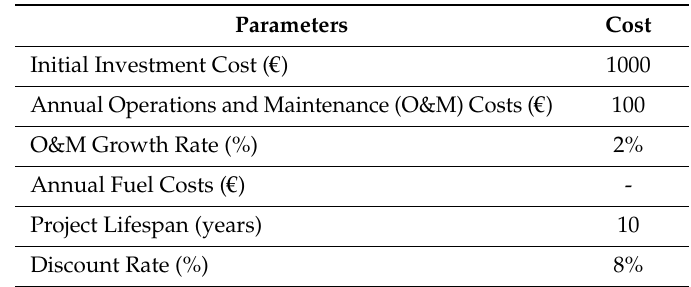
Table 1. Investment costs for mechanical and chemical treatment of barley straw to calculate LCOE and NPV .